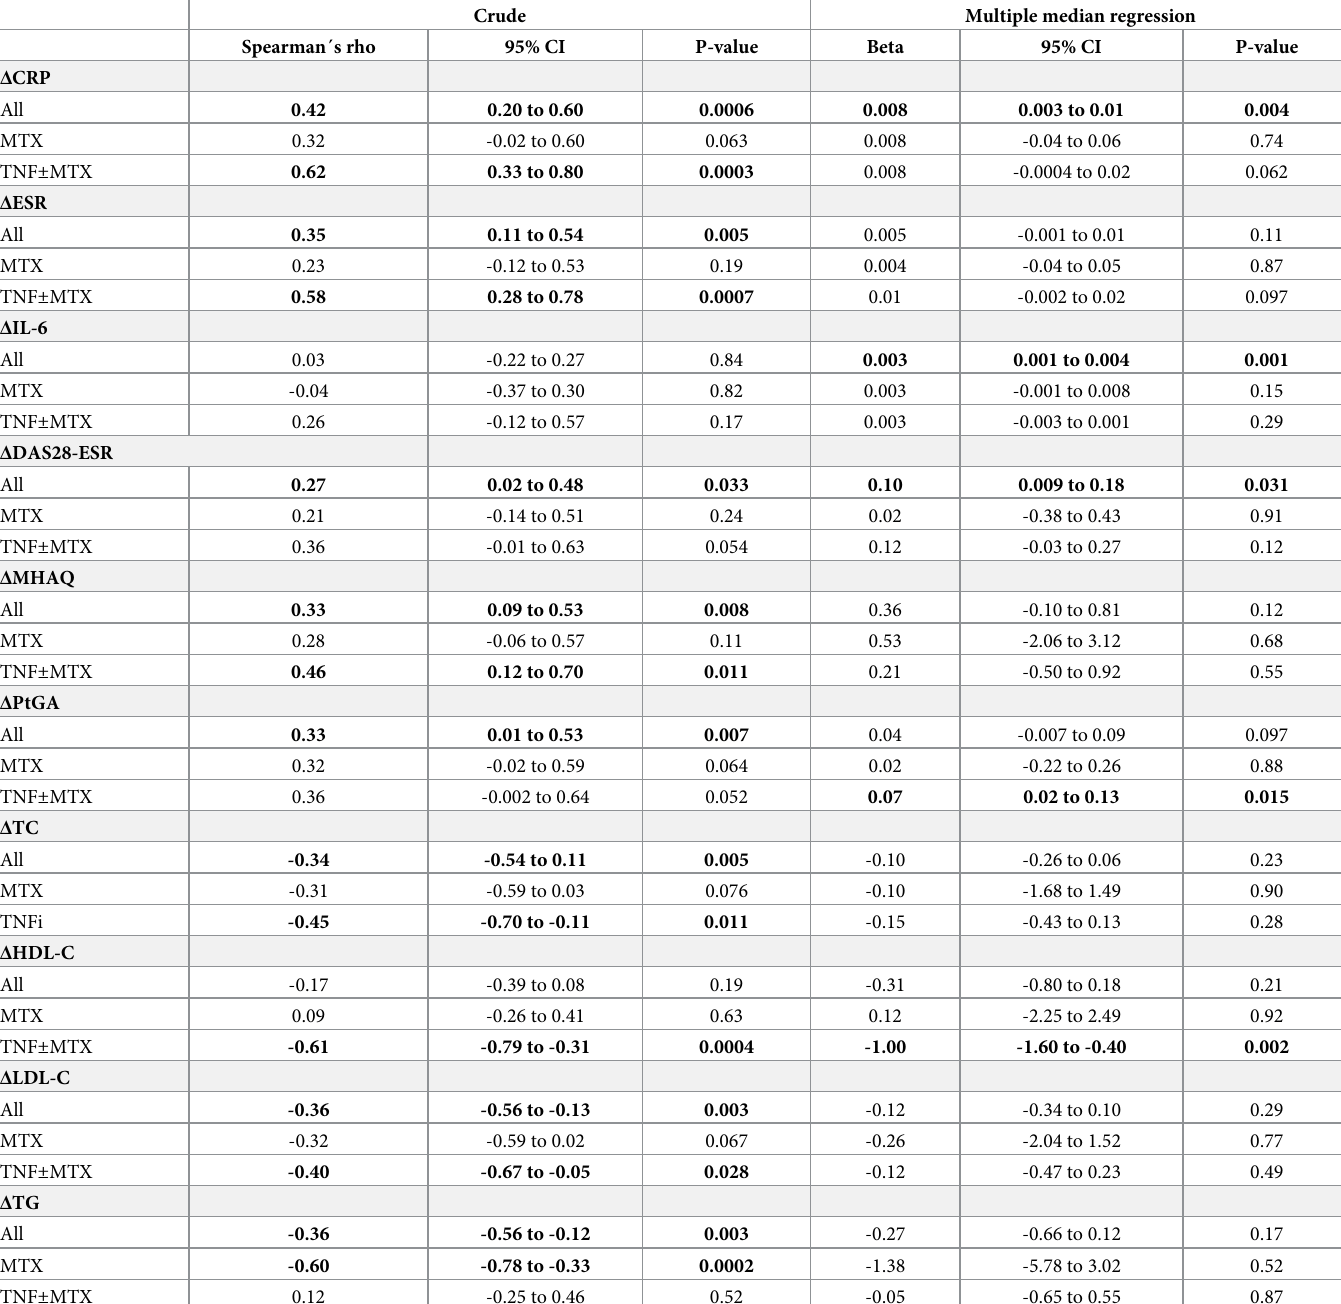
Table 6. Associations between changes in TCC and changes in selected variables after 6 months of